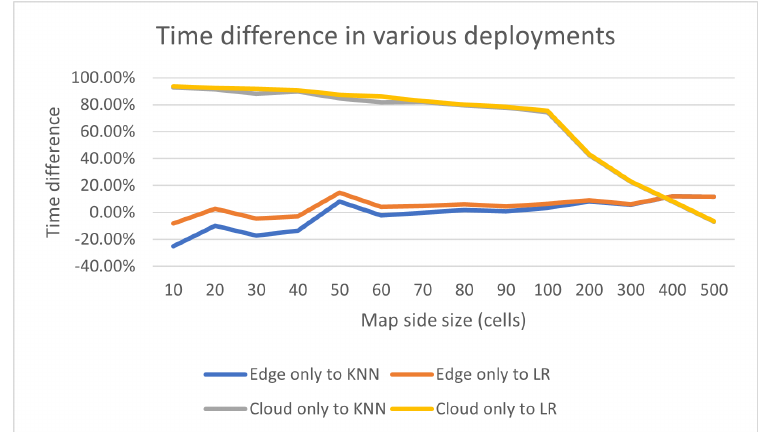
Figure 18. Time differences in various deployment